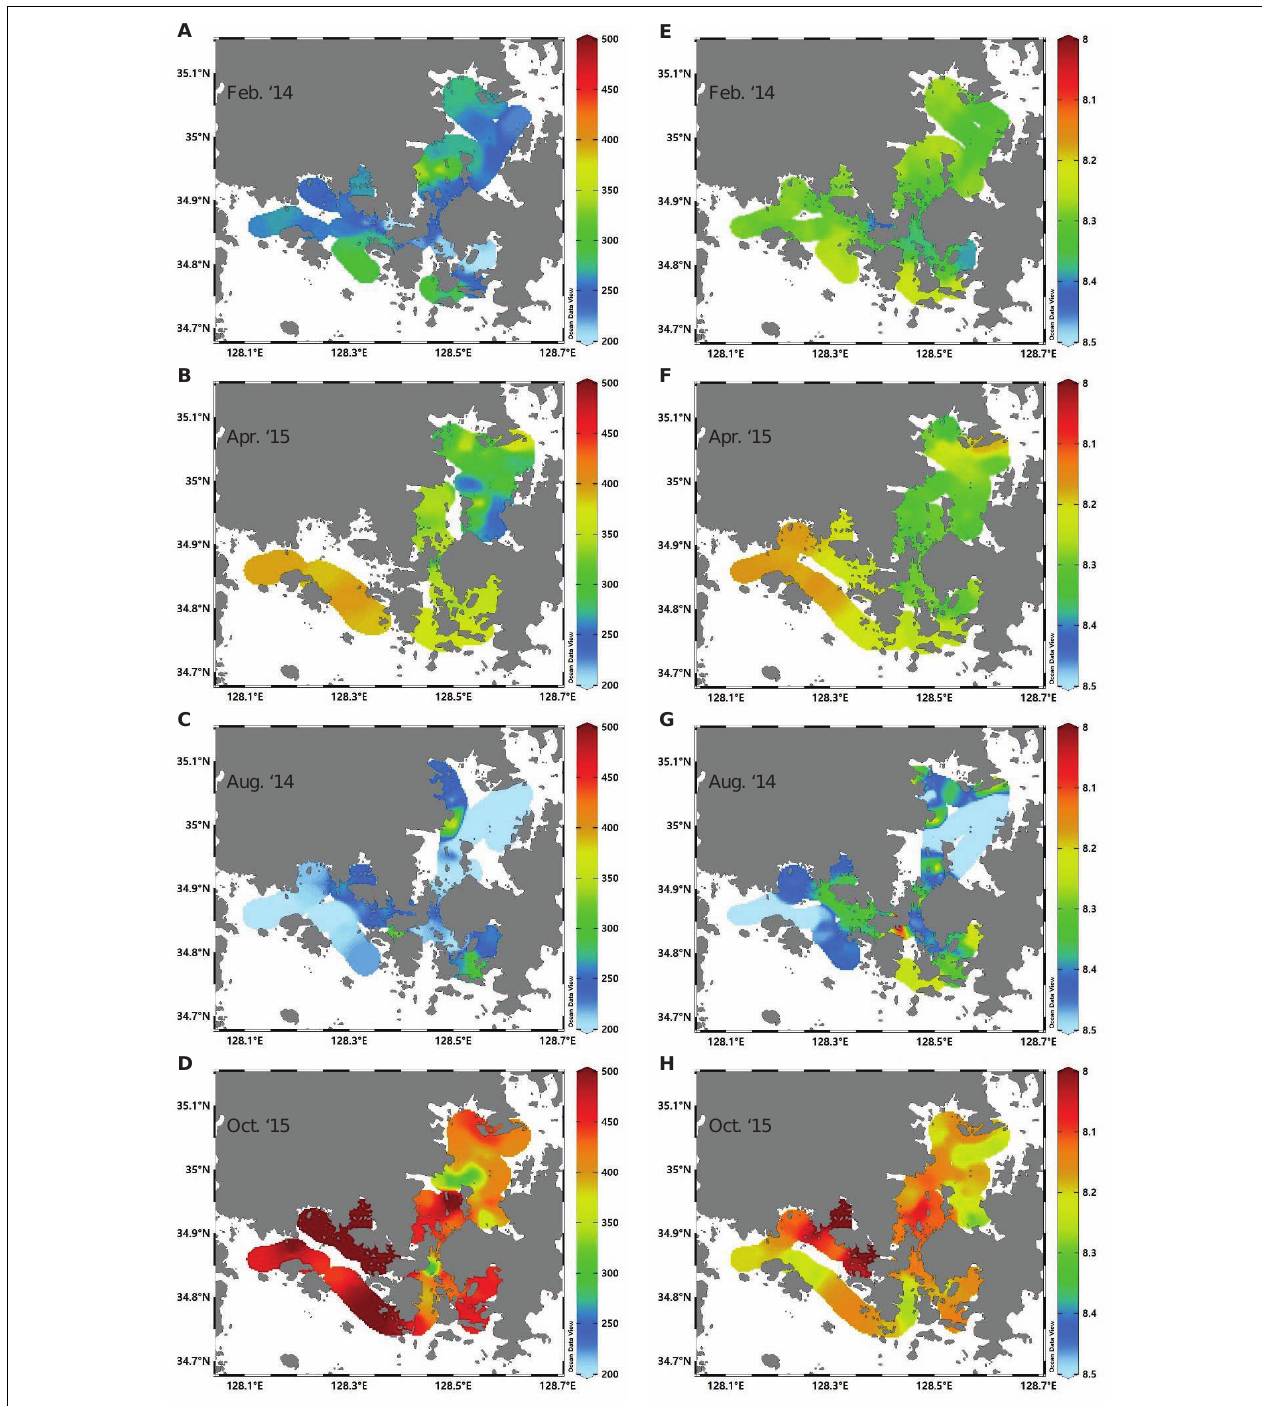
those of surface water, and low temperatures were observed at a deep water level in the inner part of area A. In October, the temperatures of surface water and bottom water showed the most